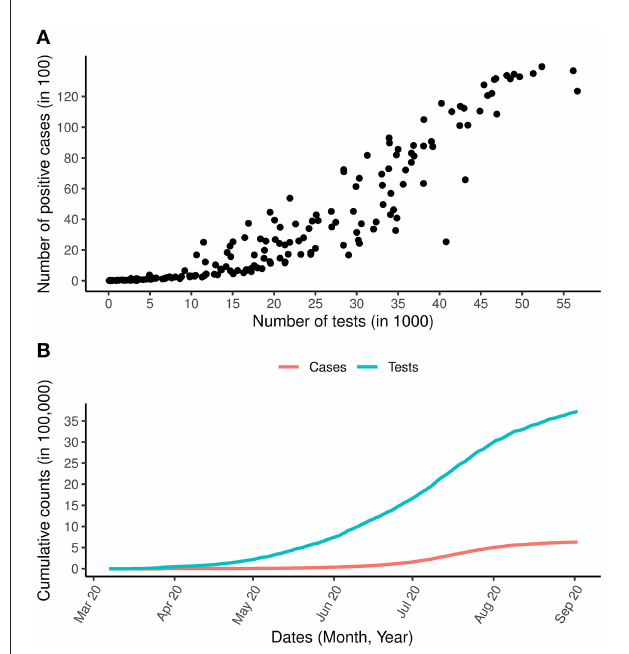
FIGURE1 COVID-19 cases and tests over time. (A) Is the relationship between the daily number of COVID-19 tests and the daily number of COVID-19 positive cases. (B) Is the total number of COVID-19 cases and total number of COVID-19 tests carried out between the